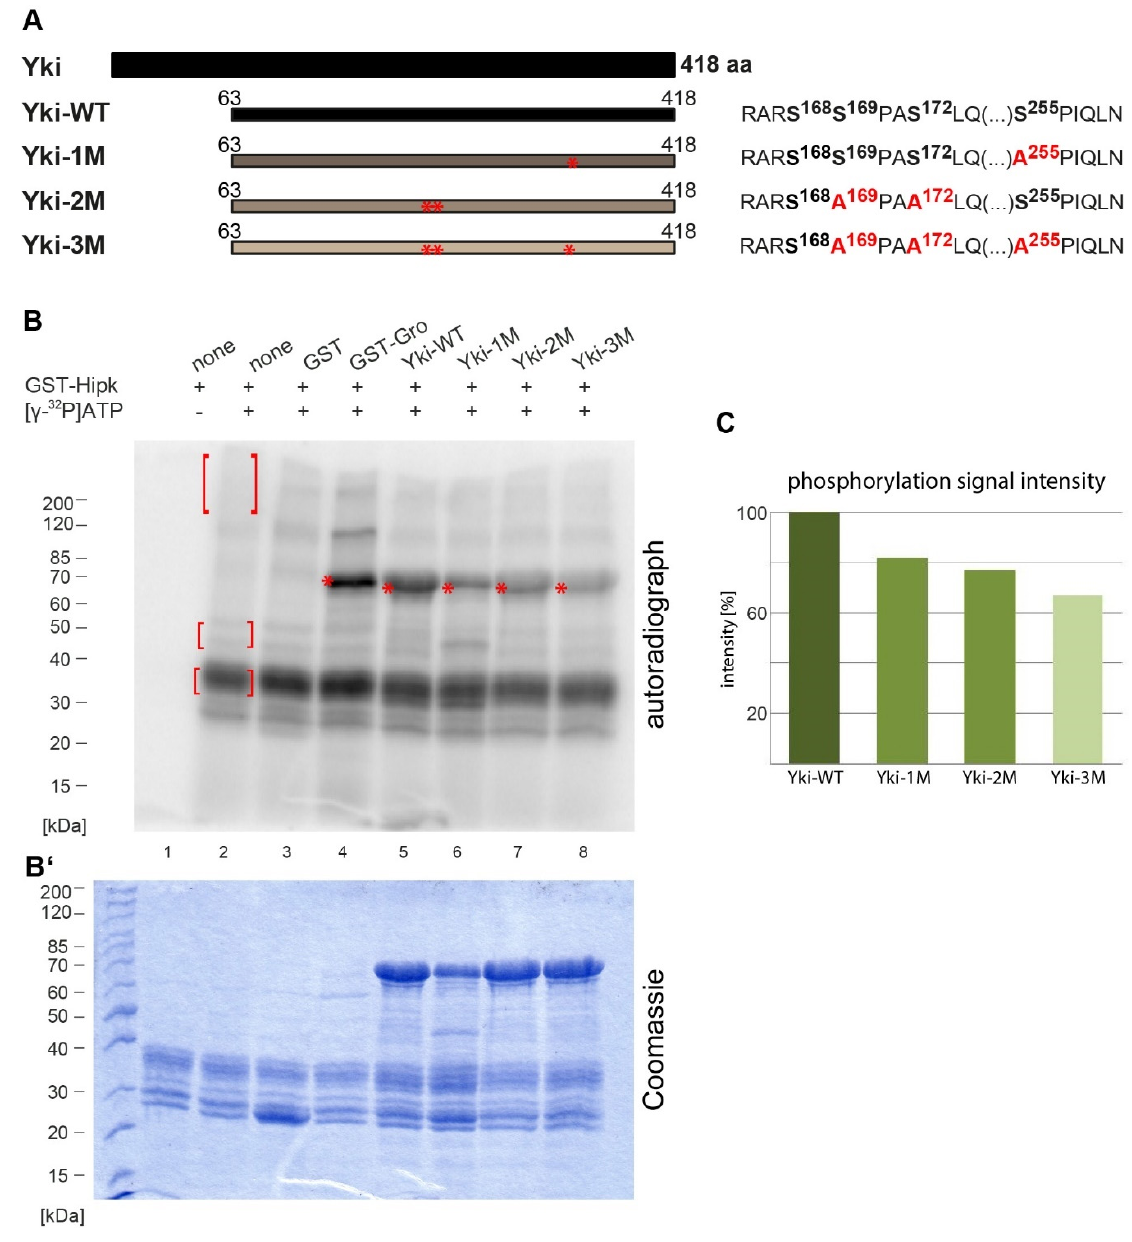
Figure 2. ( A ) Schematic view of Yki with 418 amino acids (aa). Positions and sizes of different constructs of Yki that were purified and analysed by phosphorylation assay are shown below (Yki-WT, -1M, -2M and -3M). Red asterisks highlight mutated amino acid positions; the respective amino acid sequences are shown alongside. Amino acid residues affected by the mutations are accentuated in bold; the respective mutated sites are shown in red. ( B ) Autoradiograph after in vitro phosphorylation assay of the purified Yki constructs. Each protein contained a GST-tag and was incubated with full-length GST-Hipk and radioactively labelled adenosine triphosphate ([ γ - 32 P]ATP). Controls were performed as described in Fig- ure 1. Autophosphorylation of Hipk led to a signal (see marked within red brackets), which was subtracted from substrate phosphorylation signals in the following lanes. Signals from phosphorylated proteins are marked with red asterisks. ( B’ ) Loading control according to (B): original 12%-SDS-PAGE from the phosphorylation assay, Coomassie-stained. Equal amounts of protein were used in the assay (for Yki-WT, -1M, -2M and -3M). ( C ) Quantification of the phosphorylation signal intensities according to B, using ImageJ.